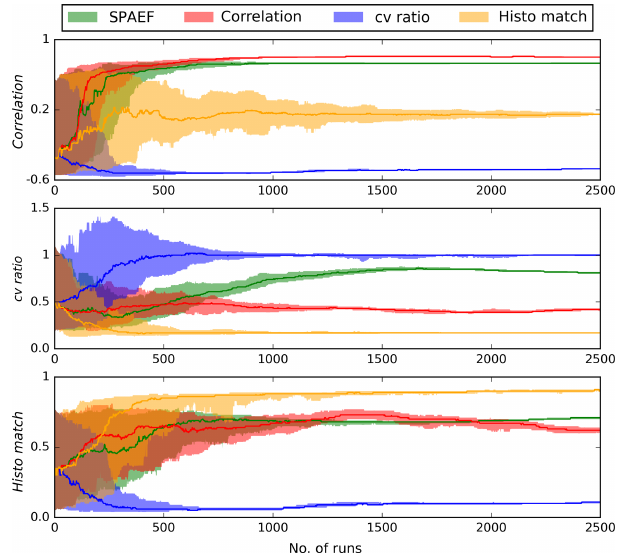
Figure 7. Tracking of the three SPAEF components throughout the 2500 conducted runs of four calibrations (SPAEF, correlation, cv ratio and histo match). The envelopes represent the 10th and 90th percentile of a 100-run moving window; the line shows the